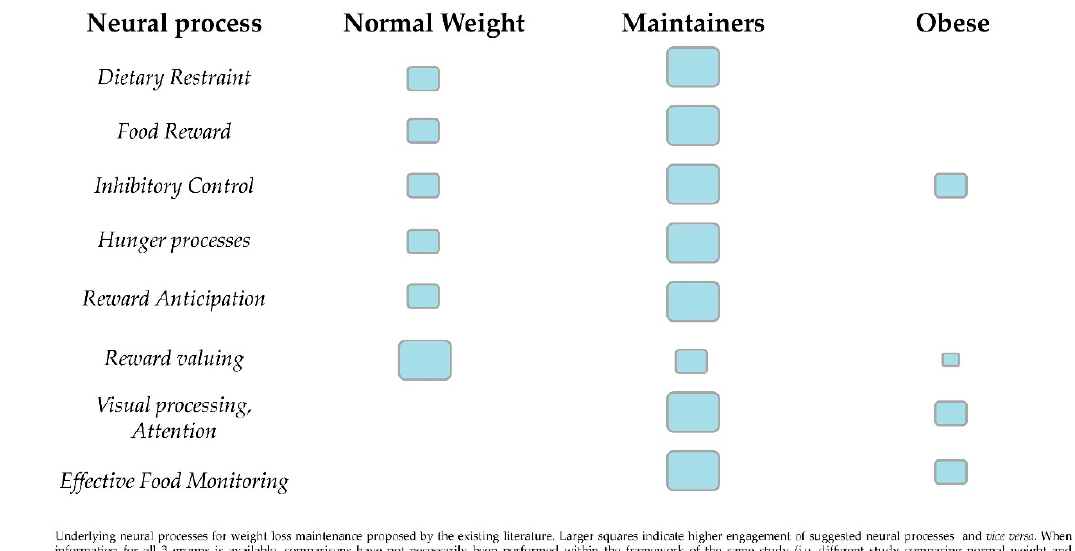
Figure 1. A summary of regional brain activity and proposed function in maintainers compared to obese and normal weight individuals.